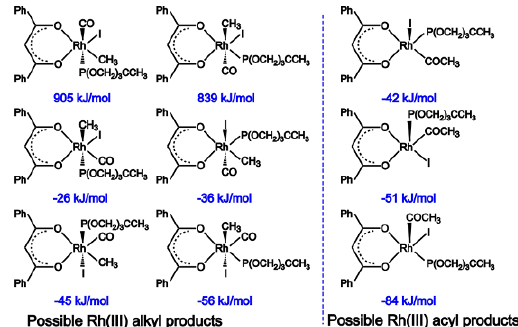
Figure 6. Geometries and ADF calculated relative energies ( ∆ E of the possible rhodium(III) alkyl and acyl products of the [Rh(PhCOCHCOPh)(CO)(P(OCH reaction. The energy of the reactants is taken as